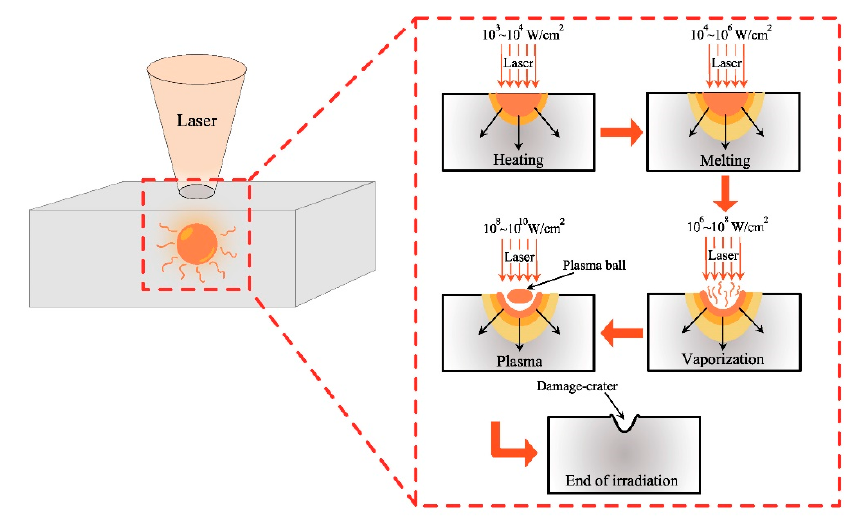
Figure 1. The physical phenomenon of the interaction of laser and optical crystal materials at different light intensity levels.